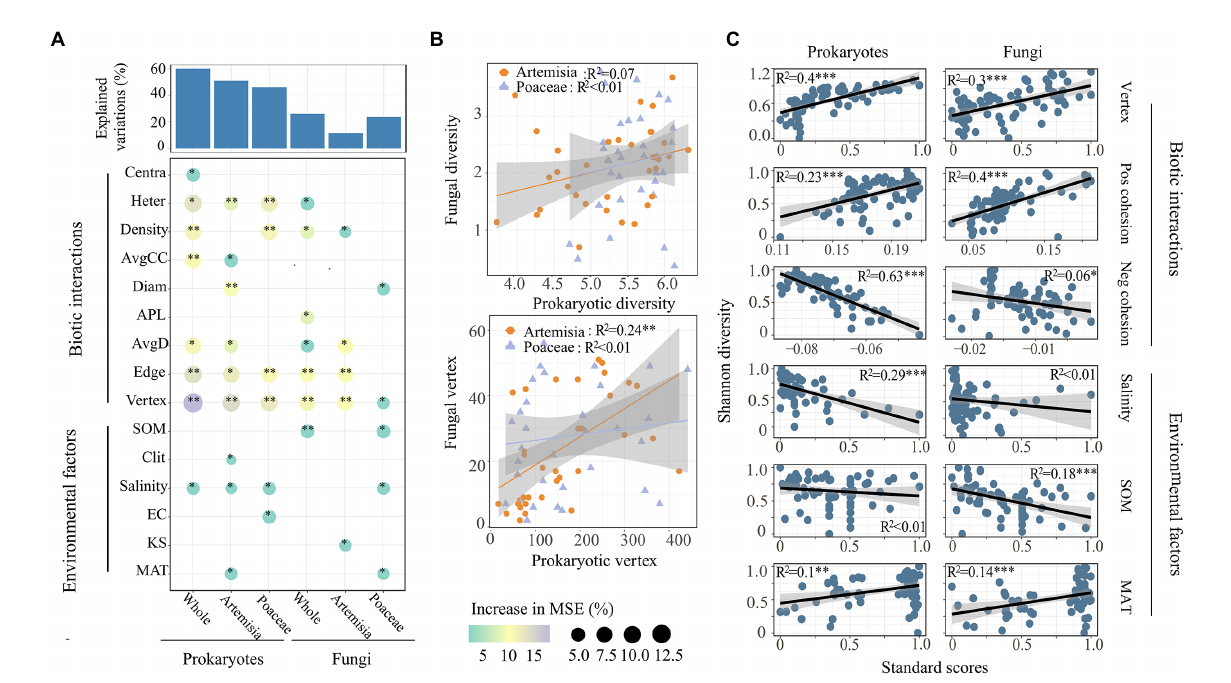
FIGURE 5 Driving factors of microbial α -diversity across habitats. (A) Contributions of different factors to prokaryotic and fungal α -diversity based on random forest model. Circle size and colour represent the variables’ importance. The abbreviations of environmental variables are in accordance with the Table 1. (B) Relationships of α -diversity and vertex number between prokaryotic and fungal communities were estimated using linear least-squares regression. (C) Relationships between microbial α -diversity and the predominant factors based on the results of the best regression model with the least AIC. Pos Cohesion indicates positive cohesion, Neg Cohesion indicates the negative